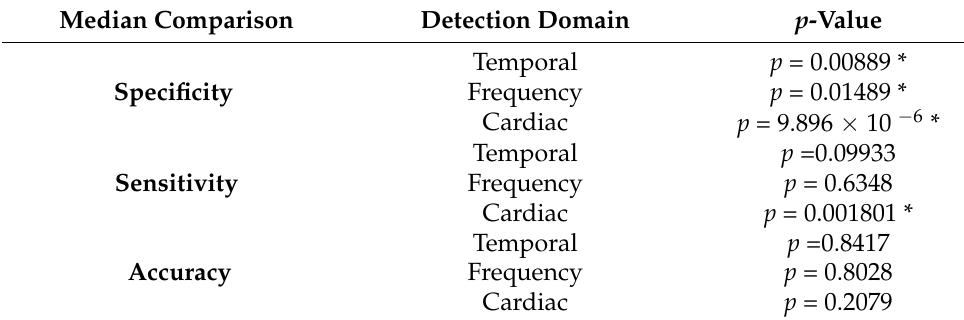
Figure 15. Box plot (as box plot of Figure 12) for specificity (blue), sensitivity (green), and accuracy (orange) of temporal (T), frequency (F), and cardiac (C) detection domains, as well as global result (G). Table 6. Median values comparing for specificity, sensitivity, and accuracy of each detection domain— single detection domain vs. combining detection domain. * p -value < 0.05, difference between the two paired samples was significantly